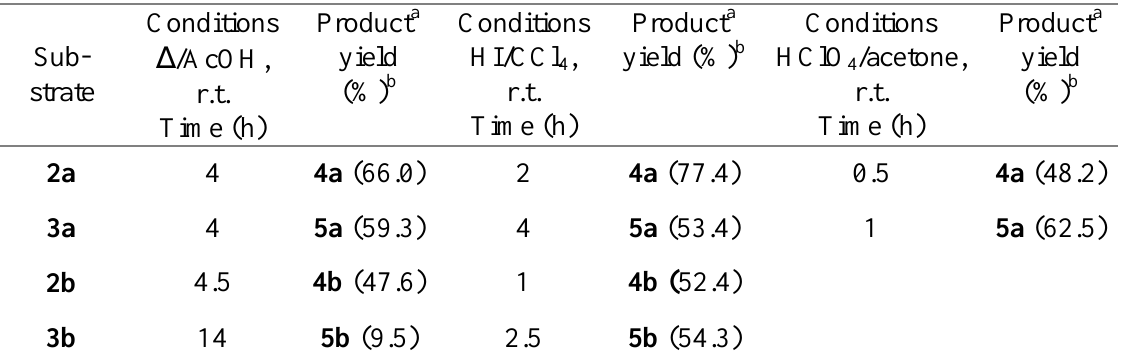
Table 1. Products of the thermal and acid-catalyzed reaction of the ( Z )- and ( E )-cyclodecenediones 2a , 3a and 2b , 3b